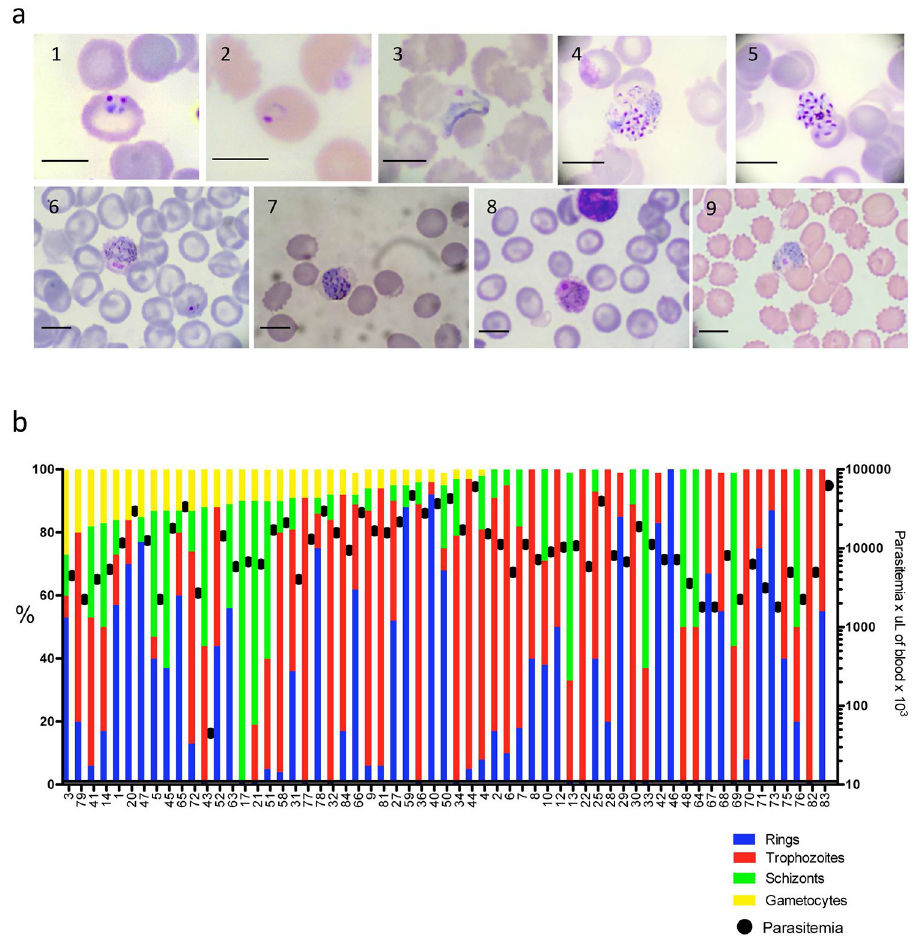
Fig 2. Microscopic detection of Plasmodium vivax asexual and sexual stages. a) Asexual and sexual stages of selected field samples: 1-2) Rings; 3) Trophozoite; 4-5) Schizonts; 6-9) Gametocytes. Giemsa stain. Black bar = 8 μ m. b) Percent parasite stages and parasitemia of selected field samples. N =